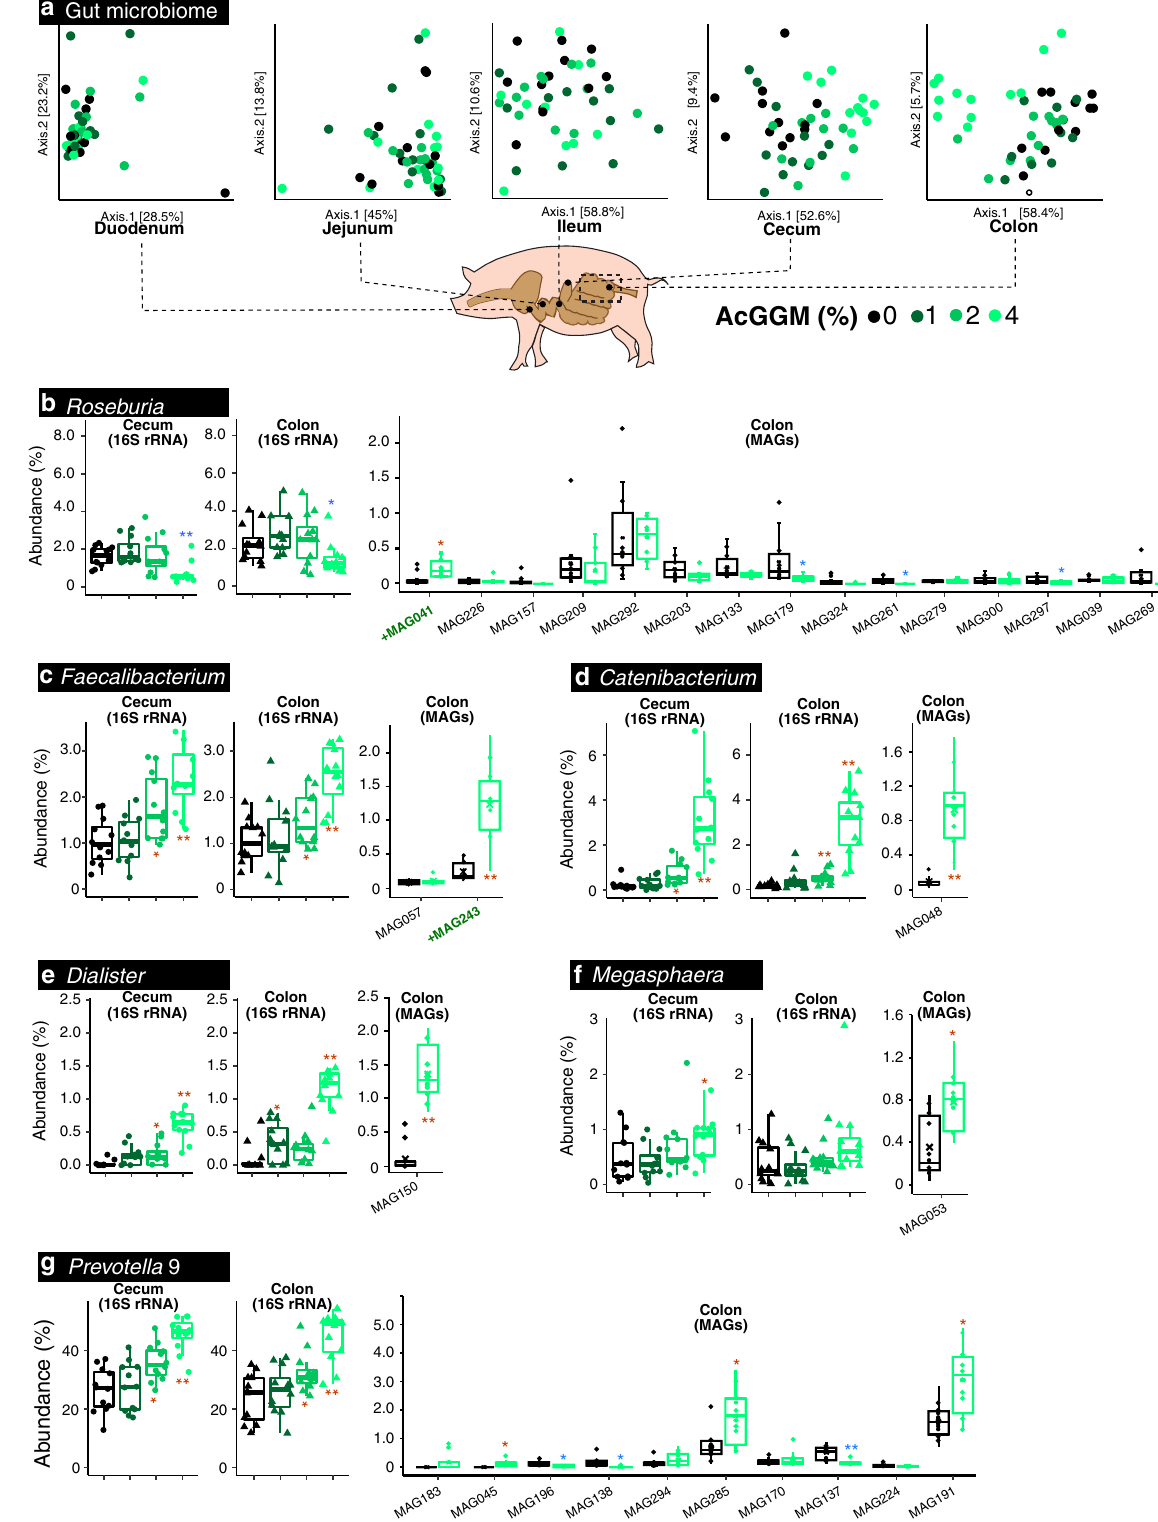
In contrast to Roseburia -af fi liated MAGs, only one MAG clustered with F. prausnitzii (MAG243, Fig. 4 and Supplementary Data 3), implying that the multiple phylotypes that were predicted with our 16S rRNA gene data (Supplementary Fig. 3c and Supplementary Data 2) encode high genome similarity and coverage and thus likely co-assembled into a